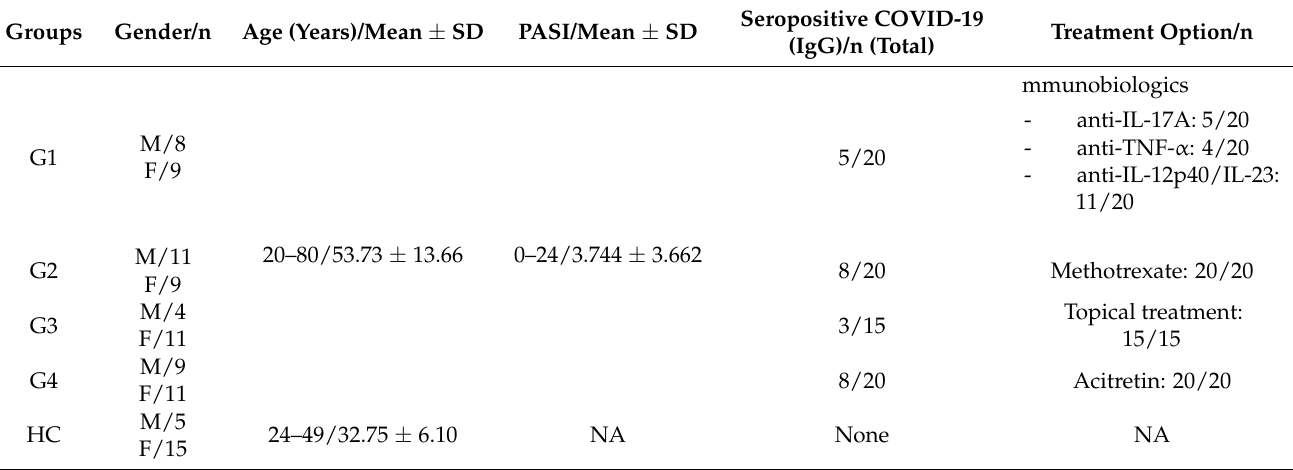
Table 1. Characterization of psoriasis patients (clinical-epidemiological features and treatment options).